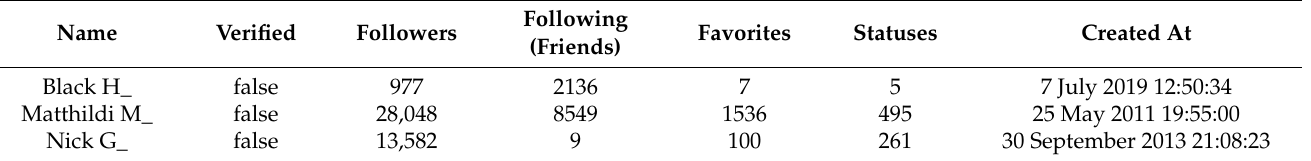
Table 2. Sample of original Data for